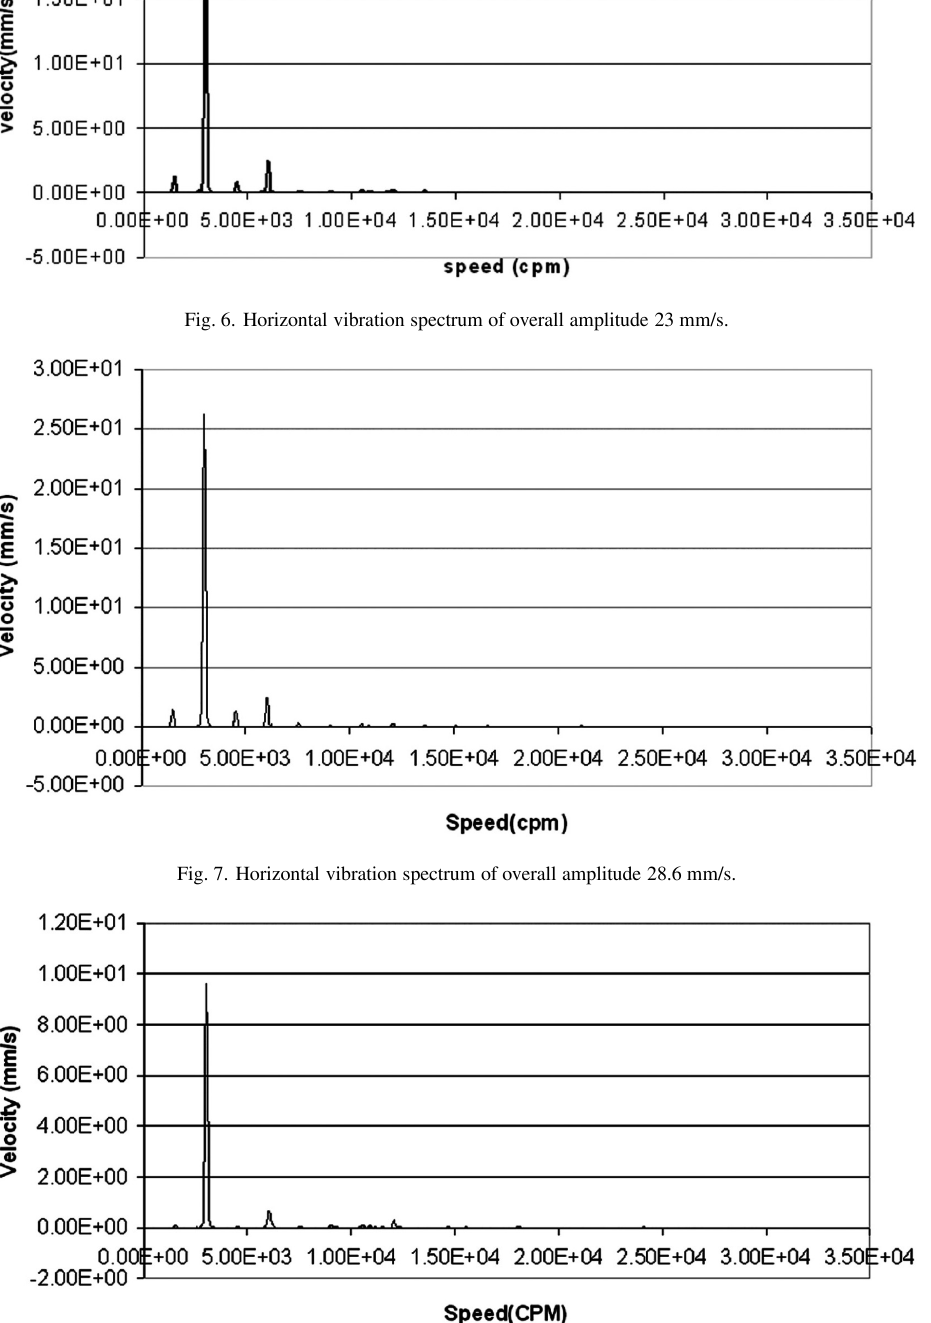
Fig. 8. Horizontal vibration spectrum of overall amplitude 9.93